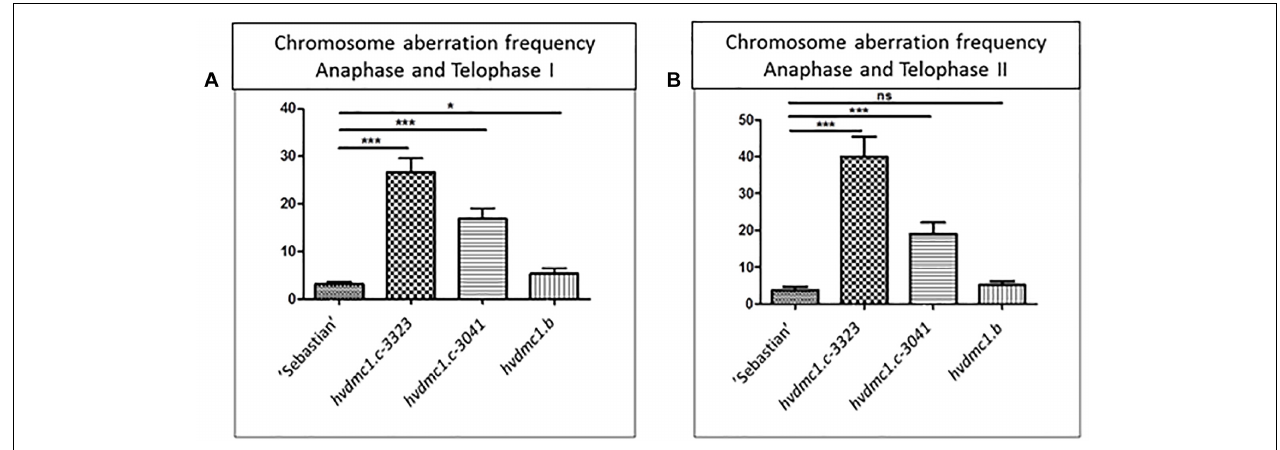
FIGURE 8 | (A) Comparison of the chromosome aberration frequencies in anaphase and telophase I in ‘Sebastian’ (wt) and three dmc1 mutants. (B) Comparison of the chromosome aberration frequencies in anaphase and telophase II in ‘Sebastian’ and three dmc1 mutants. Stars indicate statistical significant differences (ANOVA; p < 0,05) between ‘Sebastian’ and the three dmc1 mutants, ns – differences between compared genotypes were not statistically significant.